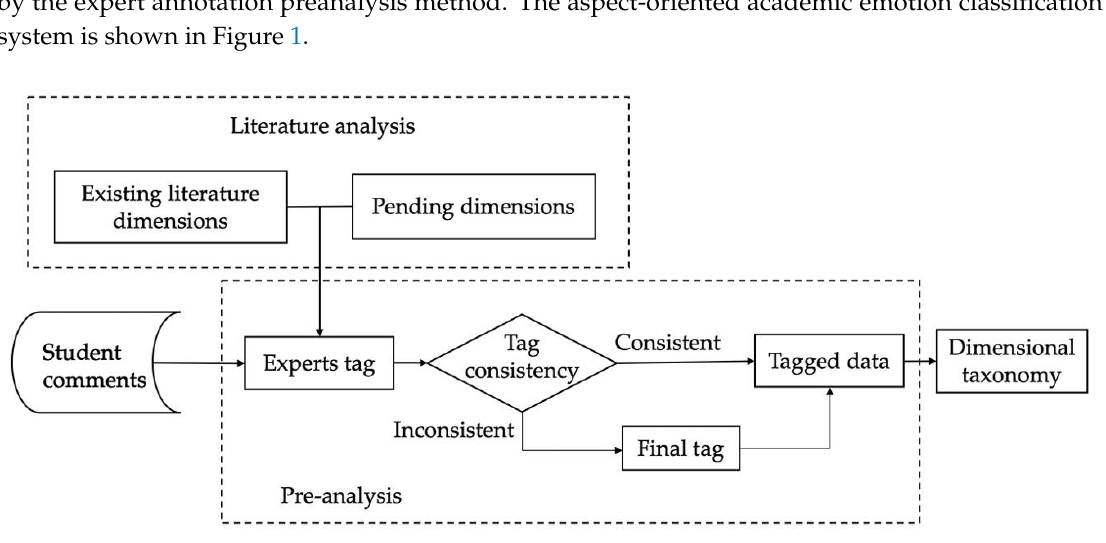
Figure 1. Aspect-oriented academic emotion classification system.